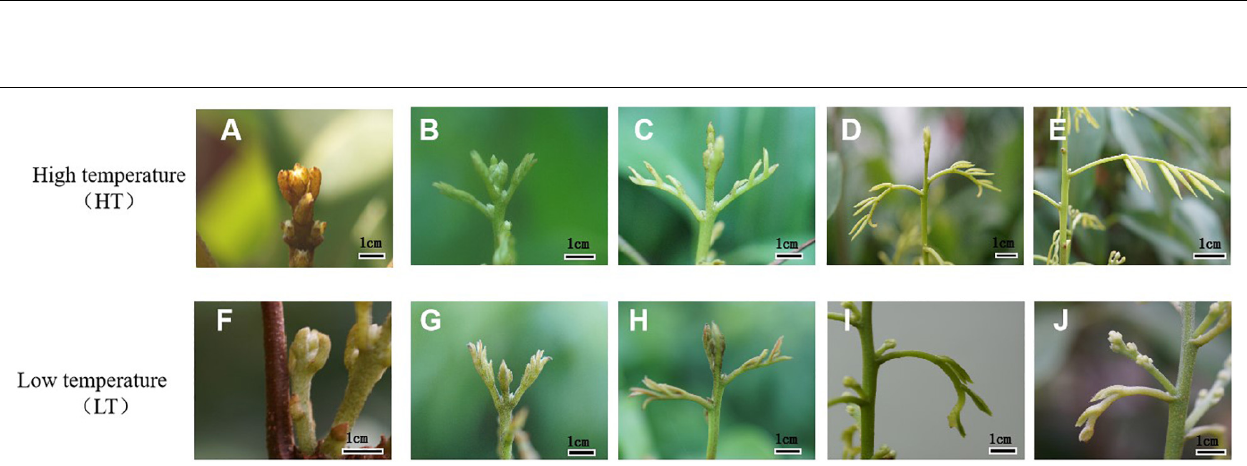
FIGURE 2 | Morphology of litchi rudimentary leaves and flower buds under HT and LT conditions. (A–E) Different developmental stages of the leaf on panicle and flower buds under HT condition. (F–J) Different developmental stages of the leaf on panicle and flower buds under LT condition.